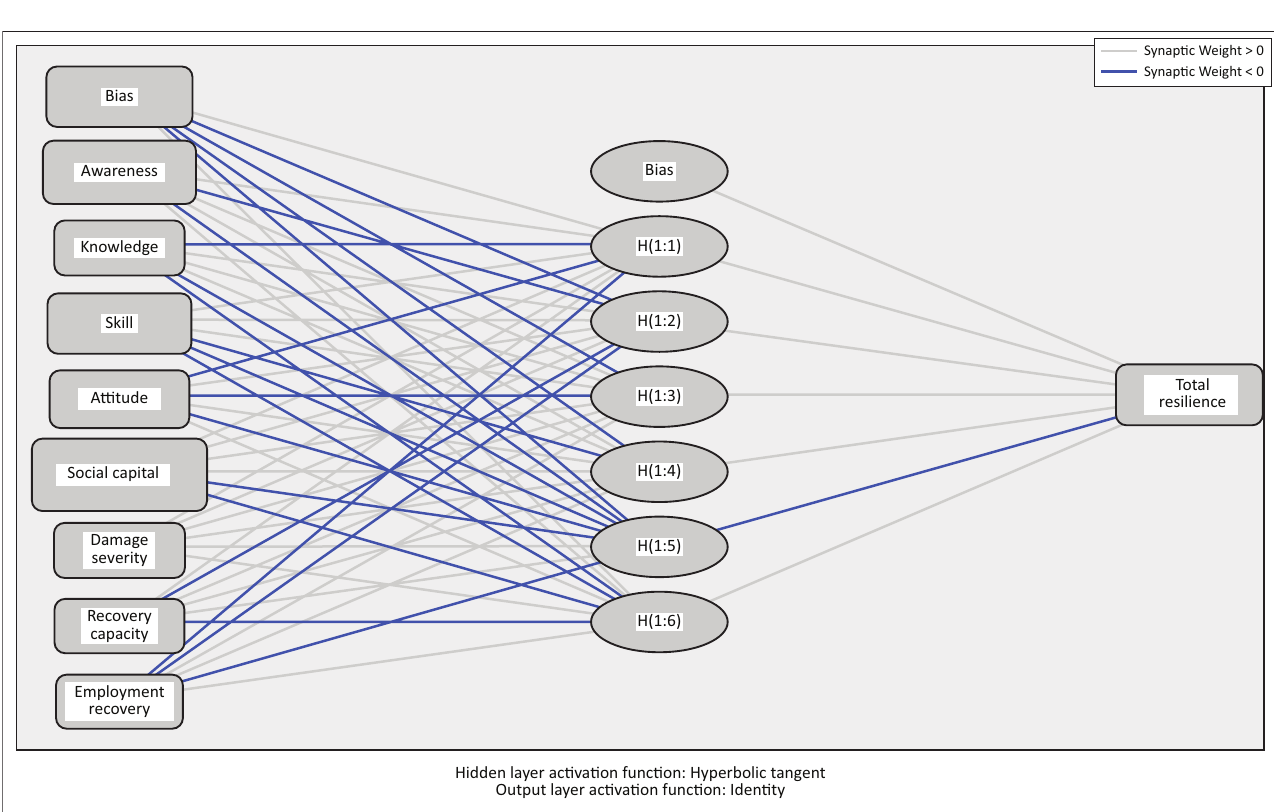
FIGURE 3: Structure of the artificial neural network of Rudbar including estimated synaptic weights.